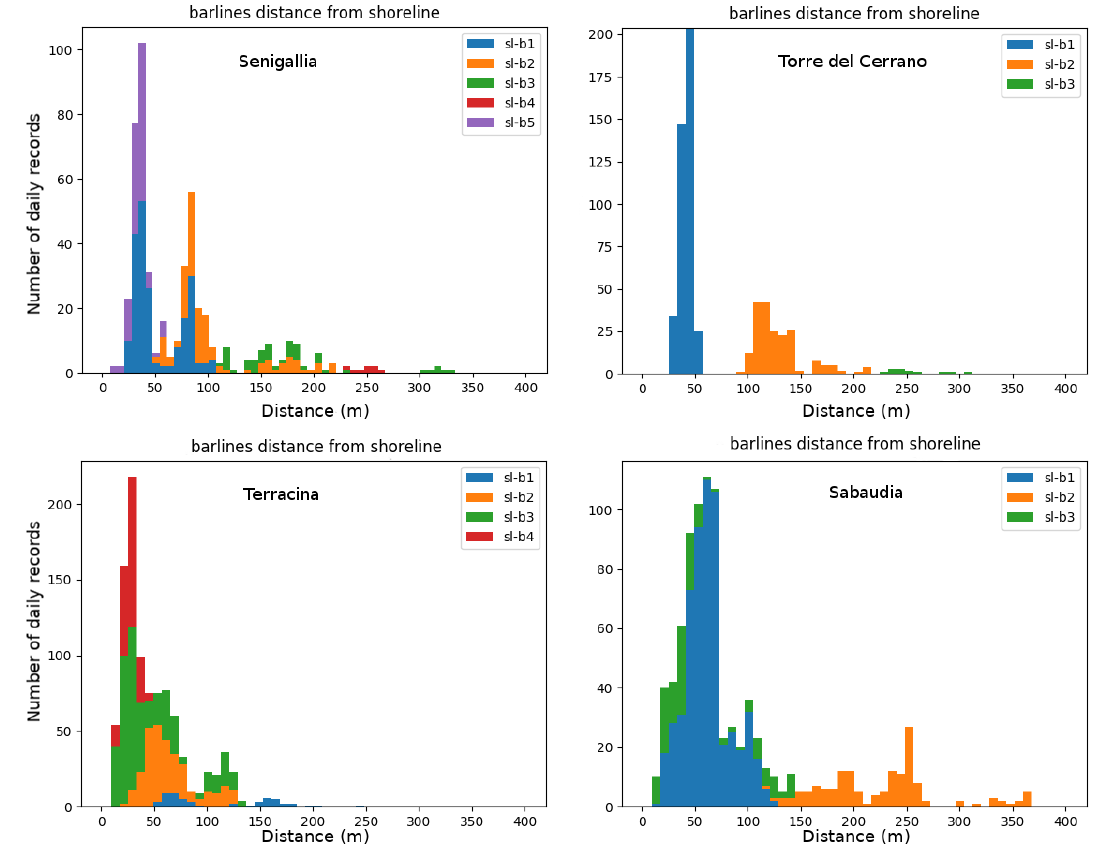
Figure 5. Distribution of distances between shoreline and bars at Senigallia, Torre del Cerrano, Terracina and Sabaudia. In the y -axis the number of daily occurrences in which the distance between a bar and the shoreline could be evaluated is reported.